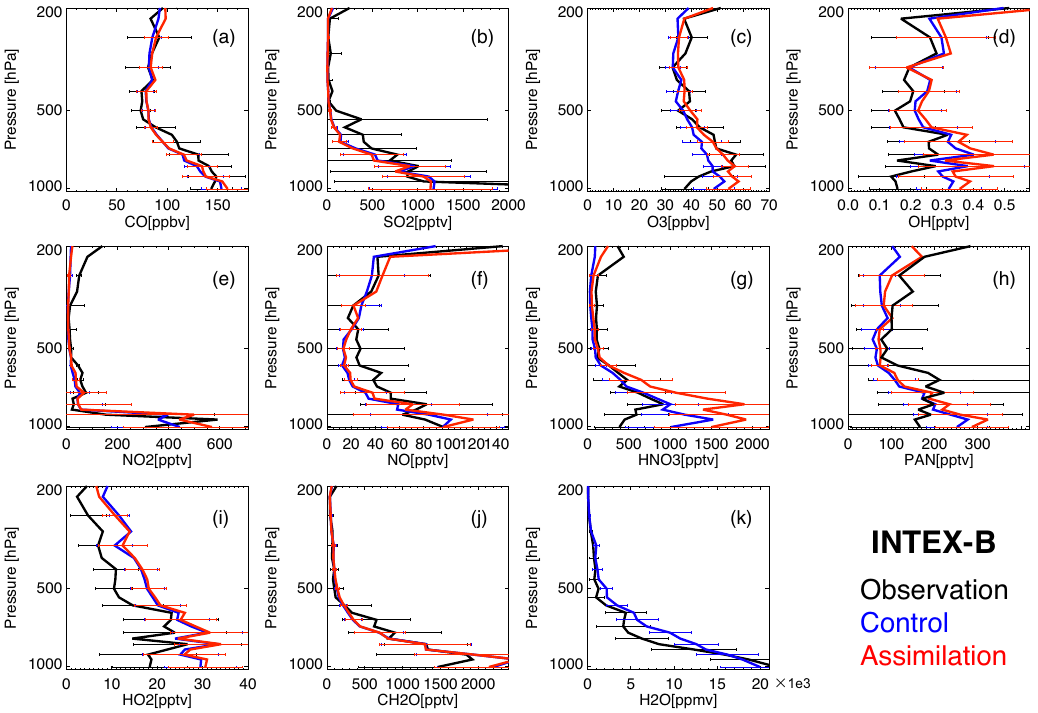
Fig. 13. Mean vertical profiles of (a) CO, (b) SO 2 , (c) O 3 , (d) OH, (e) NO 2 , (f) NO, (g) HNO 3 , (h) PAN, (i) HO 2 , (j) CH 2 O, and (k) H 2 O, obtained from aircraft measurements (black), the control run (blue), and the data assimilation (red), during the INTEX-B campaign, March 2007. The error bars represent the standard deviation of all the data within one bin (with an interval of 30hPa). Table 7. The 15-day means (from the 16–30 of each month) and the standard deviations (from the means) of the regional surface NO x emissions ( e( NO x ), in TgNyr − 1 ) for Eastern China (110–123 ◦ E, 30–40 ◦ N), Europe (10 ◦ W–30 ◦ E, 35–60 ◦ N), the Eastern United States